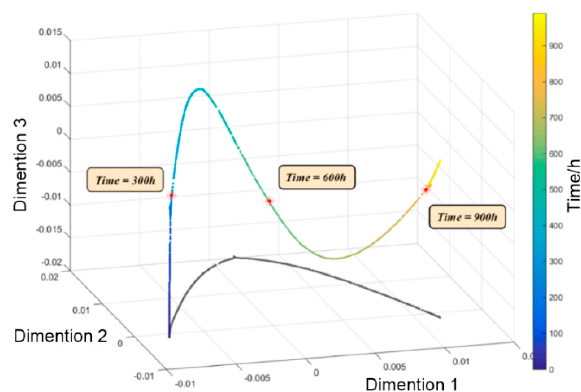
Figure 12. Trends of degradation characteristics after manifold dimension reduction using the method.